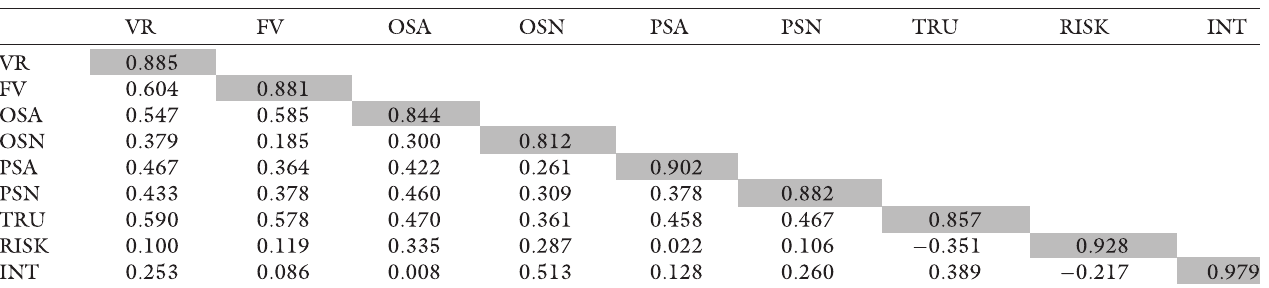
Table 2. Discriminant